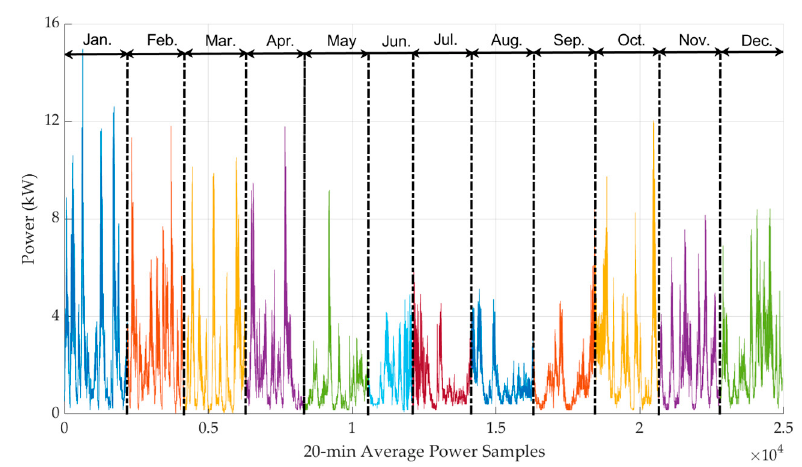
Figure 4. Optimal 20-min average power time series in 2015.